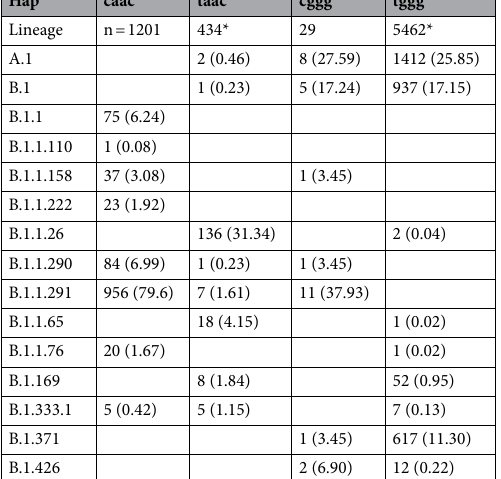
Table 6. Relationships of identified SNV haplotype (t19839-g28881-g28882-g28883) with lineages assigned by Pangolin. *Corresponding lineages associated with "taac" only or "tggg" only are excluded. For a complete list, see a separate